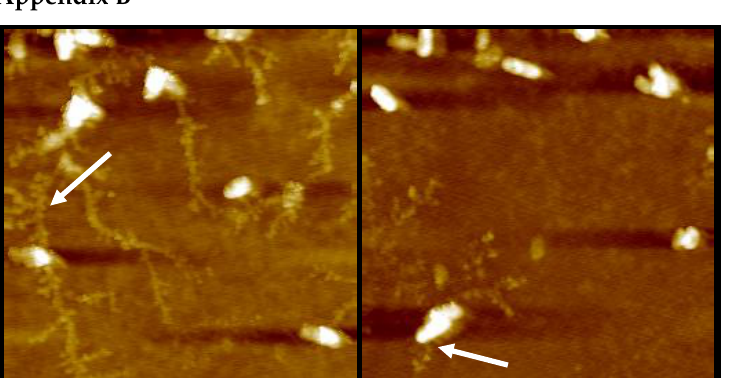
Figure A2. Two representative 20 µm × 20 µm AFM images visualizing extracellular content surrounding individual bacteria (PACF) after 18 h incubation in the presence of PL, liposomes without inclusion of CL. White arrows highlight extracellular structures emanating from individual bacteria. PL liposomes have a smaller diameter than CL-PL liposomes (85 nm versus 125 nm) and are not discernible in these images.